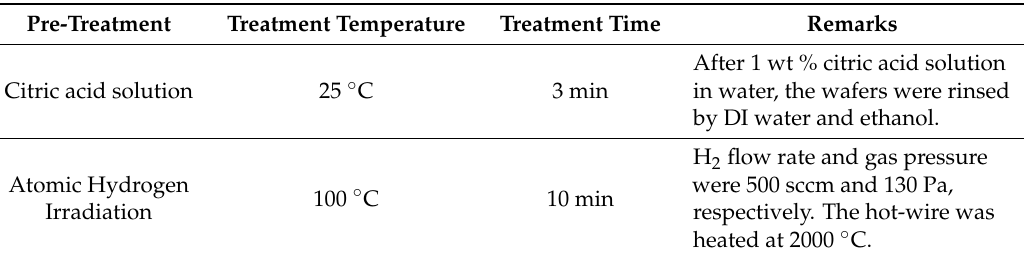
Table 1. Pre-treatment conditions.